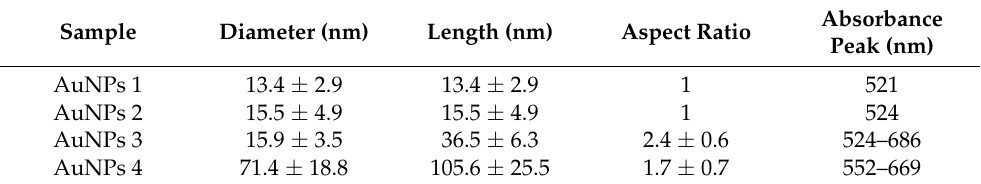
Figure 1. SEM micrographs at two different magnifications for ( a , b ) AuNPs 1, ( c , d ) AuNPs 2, ( e , f ) AuNPs 3, and ( g , h ) AuNPs 4 samples. Table 1. Summary of the nanostructure morphological and optical properties.